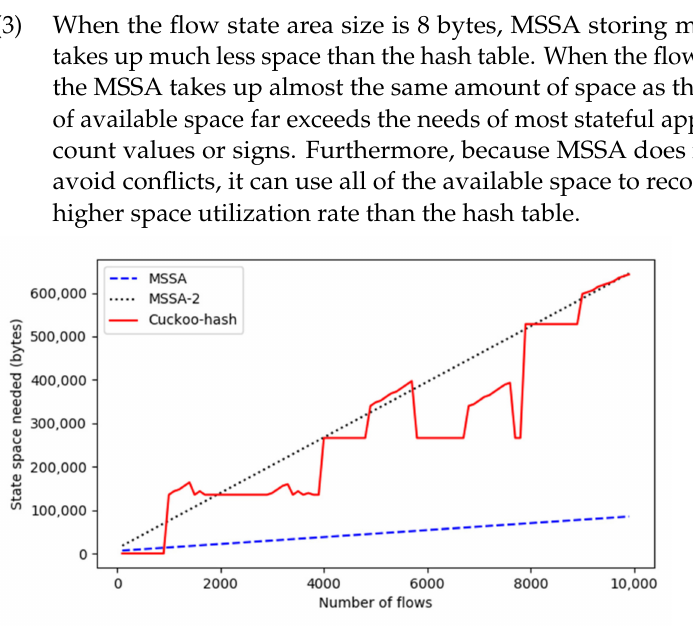
Figure 15. Compare the space consumption of using MSSA and hash table to record